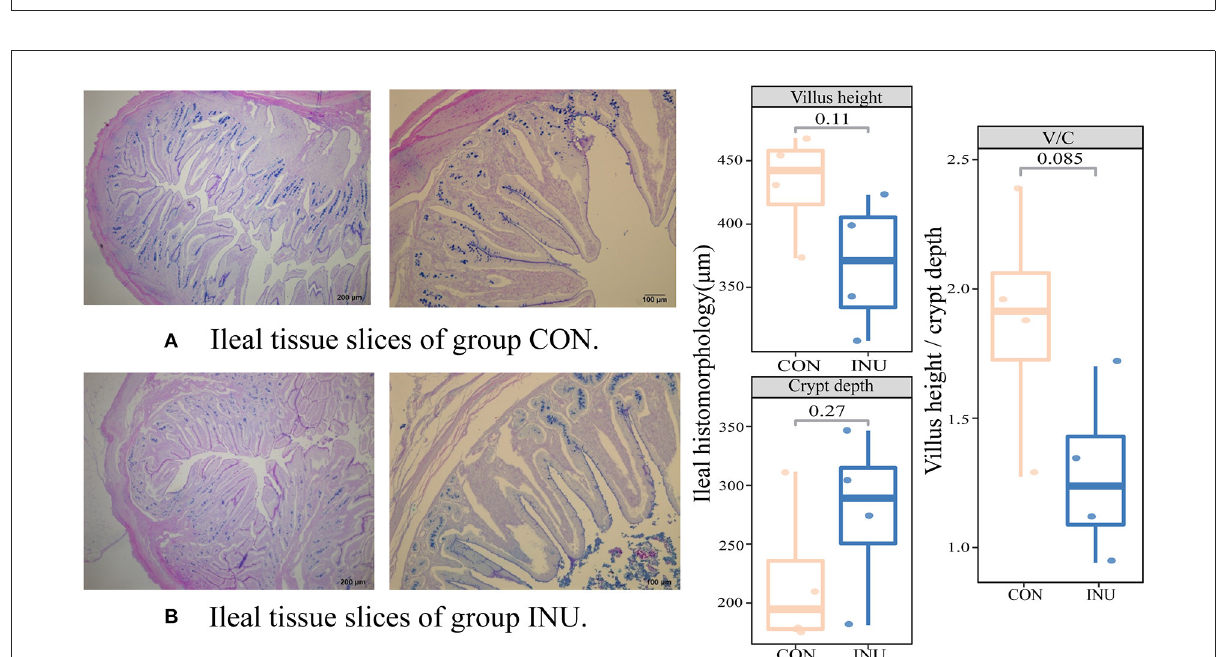
FIGURE3 Haematoxylin-eosin staining of and morphological indexes of ileal tissue. (A) is the group CON, (B) is the group INU. V/C is the ratio of villus height to crypt